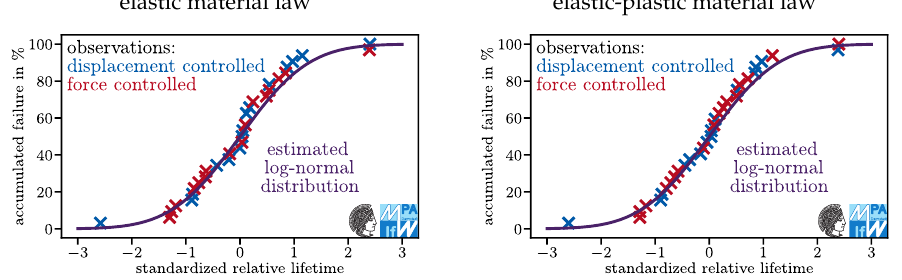
Figure A6. Estimated and observed accumulated failure rates for 50CrMo4 specimens in laboratory air; 1726MPa ultimate tensile strength; K t = 2.06.